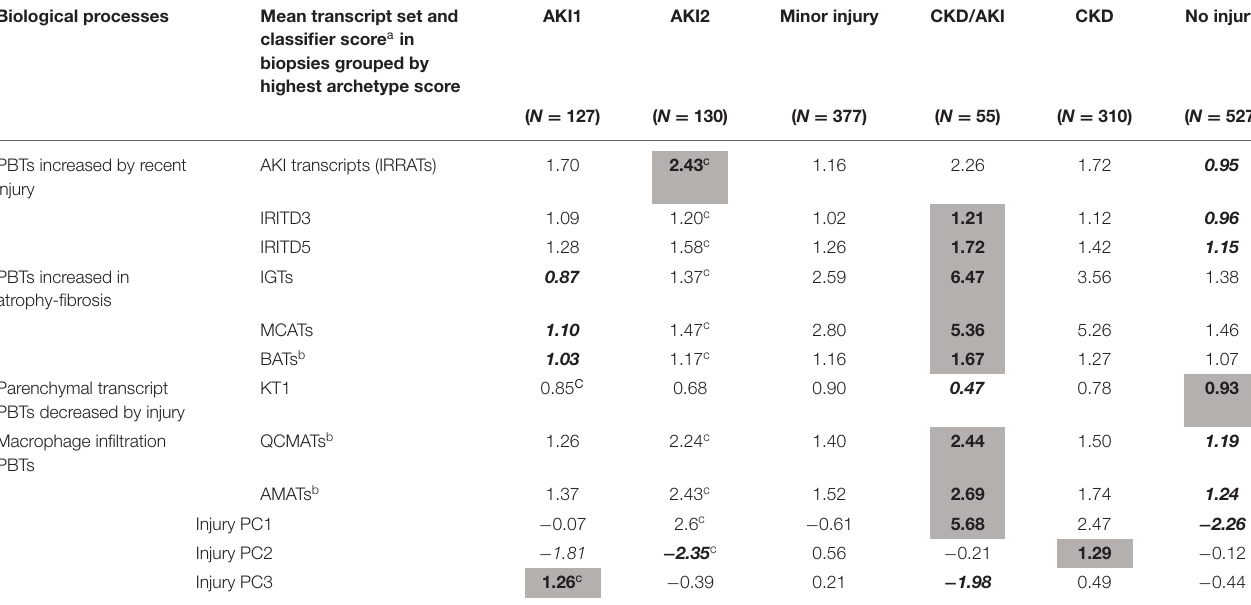
TABLE 2 | Mean scores for AKI and CKD-related pathogenesis-based transcript sets (PBTs) in injury archetype groups ( N = 1,526). Biological processes Mean transcript set and classifier score a in biopsies grouped by highest archetype